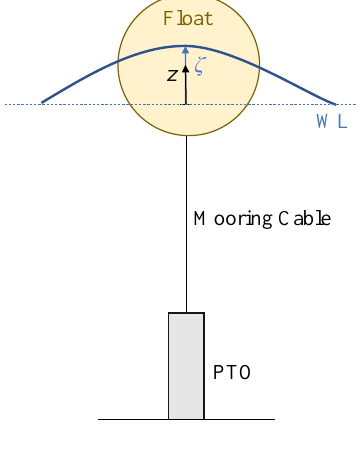
Figure 1. Heaving point